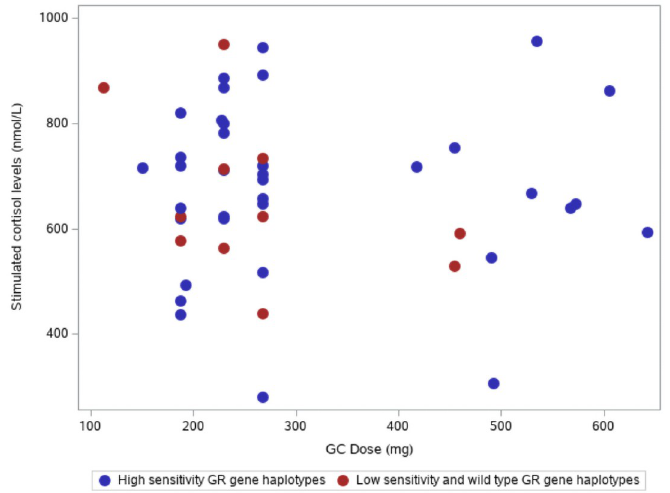
Fig 1. The relationship between total accumulated systemic glucocorticoid dose (prednisolone equivalent dose, mg) in the 6 months before the corticotropin test and stimulated cortisol concentrations for the high-sensitivity glucocorticoid receptor gene haplotype group ( p -value 0.79) compared with the low-sensitivity and wild-type glucocorticoid receptor gene haplotype group ( p -value 0.26). Abbreviations: GC, glucocorticoids; GR, glucocorticoid receptor.